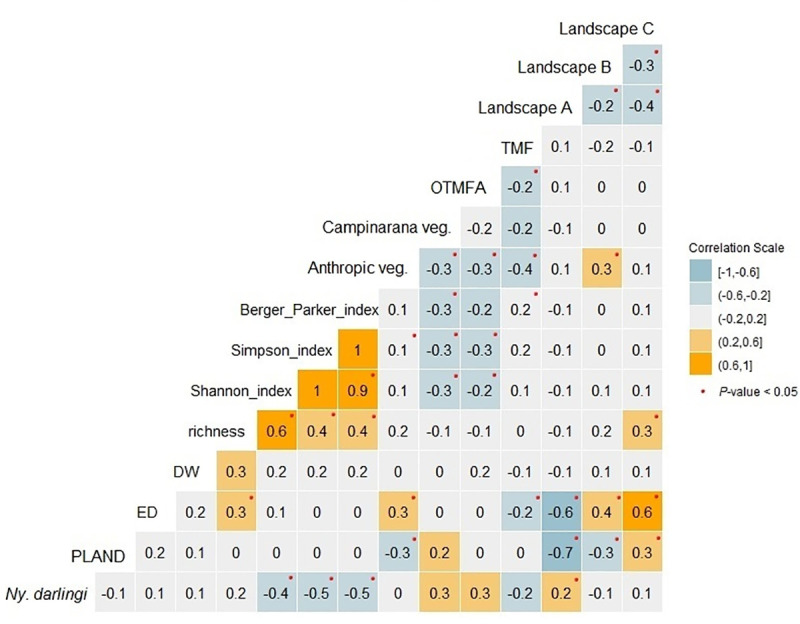
Correlation matrix among Ny. darlingi abundance, PLAND, ED, richness, DW, diversity indices (richness, Shannon, Simpson and Berger-Parker), Amazonian vegetation classes (Atp: Anthropogenic; OTMFA: Open Tropical Moist Forest with Arecaceae dominance; TMF: Tropical Moist Forest; Cpn: Campinarana), and landscape structures (A: PLAND ≤ 50% and ED < 0.015 m/ha; B: PLAND ≤ 50% and ED ≥ 0.015 m/ha; C: PLAND > 50% and ED ≥ 0.015 m/ha). PLAND: percentage of forest cover; ED: edge density; DW: distance of household from water drainage network.